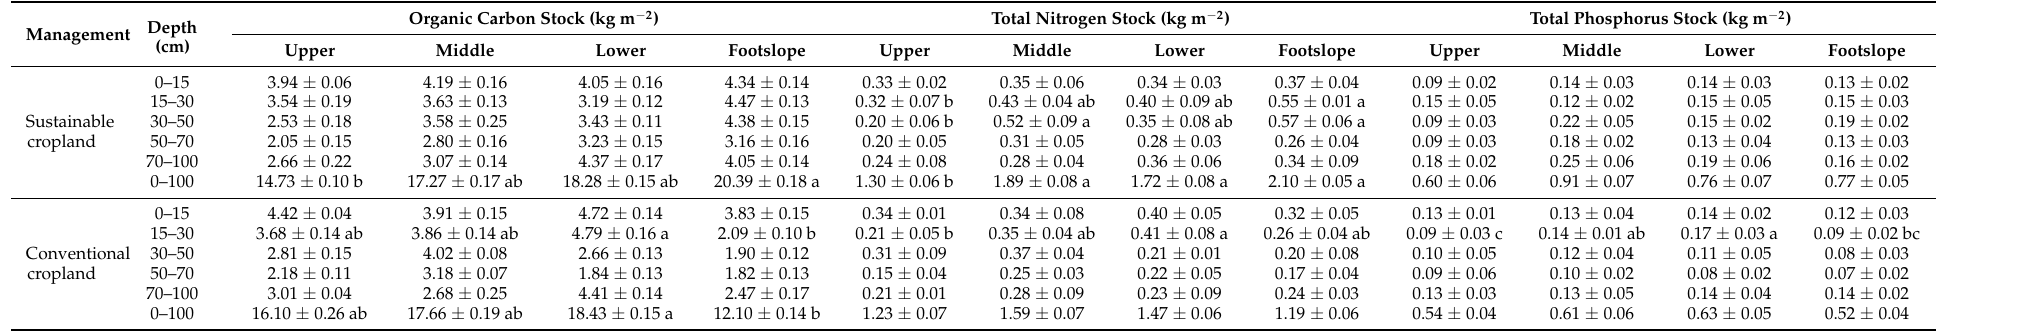
Table 2. Effect of slope position (i.e., upper slope, middle slope, lower slope, and footslope positions) on the stocks of organic carbon, total nitrogen, and total phosphorus at different depths of the two different cropland management systems (i.e., sustainable cropland and conventional